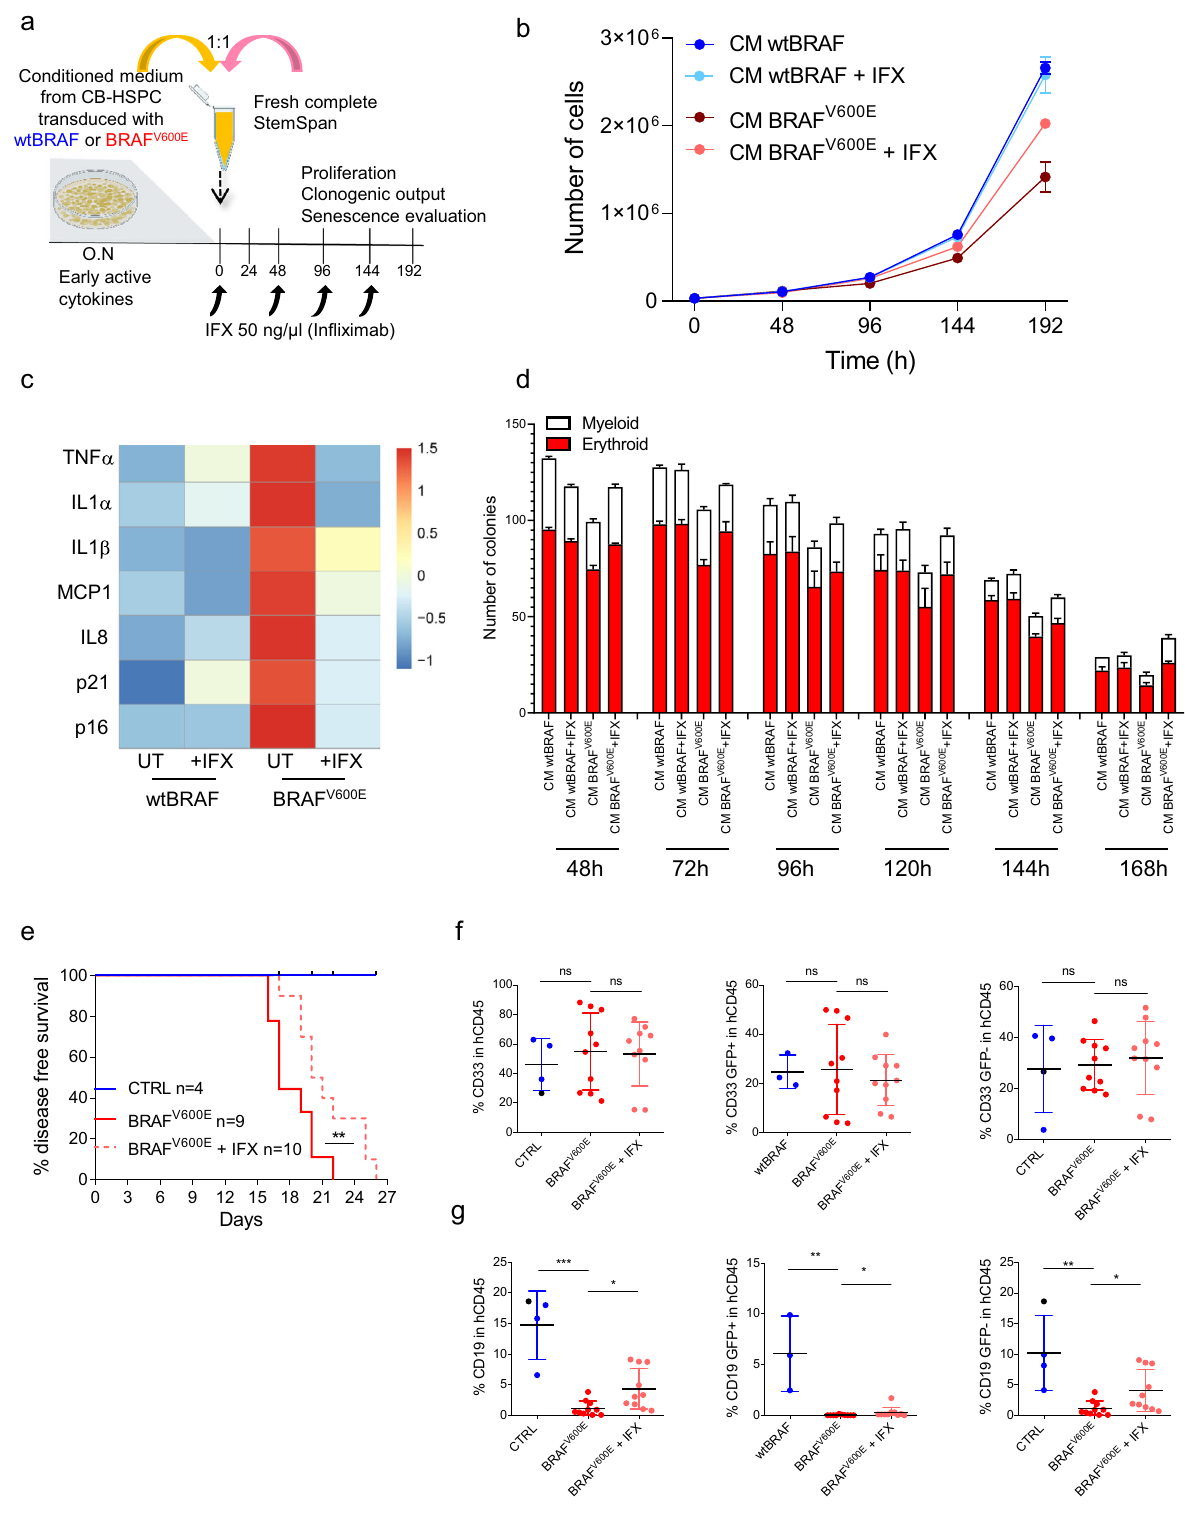
Gene expression analysis . Total RNA was isolated either using miRNeasy Micro Kit (QIAGEN) with DNase treatment through RNase-free DNase Set (QIAGEN) or using RNeasy Plus Micro Kit (QIAGEN), according to the manufacturer ’ s instructions. cDNA was obtained with iScript cDNA Synthesis Kit (Bio-Rad) then pre-ampli fi ed with TaqMan PreAmp Master Mix (Ther- moFisher). Finally, transcripts were quanti fi ed through q-PCR using Fast SYBR Green Master Mix (ThermoFisher) in a Viia7 Real-time PCR thermal cycler. The concentration of primers was determined through standard curve method